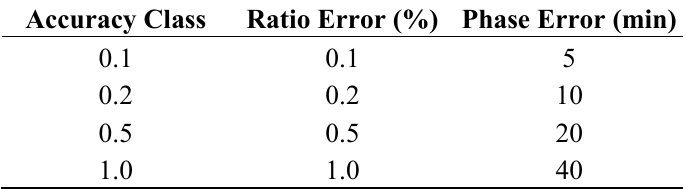
Table 1. Accuracy class for the measurement voltage transformer of IEC